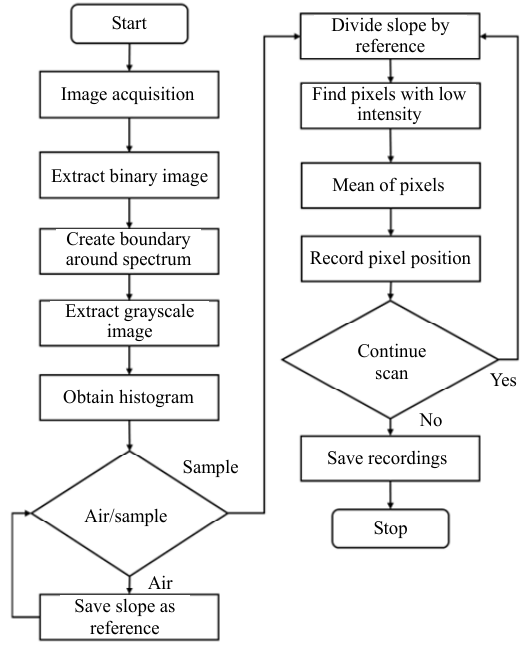
Fig. 15 Second approach of image processing, involved in automatic selection of spectra, and its analysis for finding the dip position.